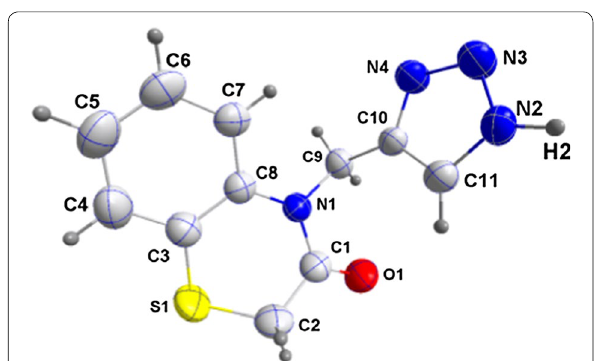
Fig. 3 Molecular structure of the compound 13 with the atom-labelling scheme. Displacement ellipsoids are drawn at the 50% probability ellipsoids (CCDC 1564624)